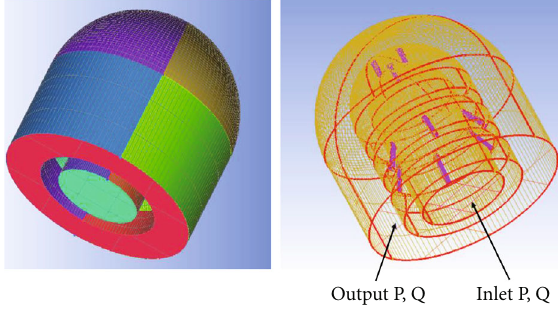
Figure 3: The meshing model of multiori fi ce nozzle.